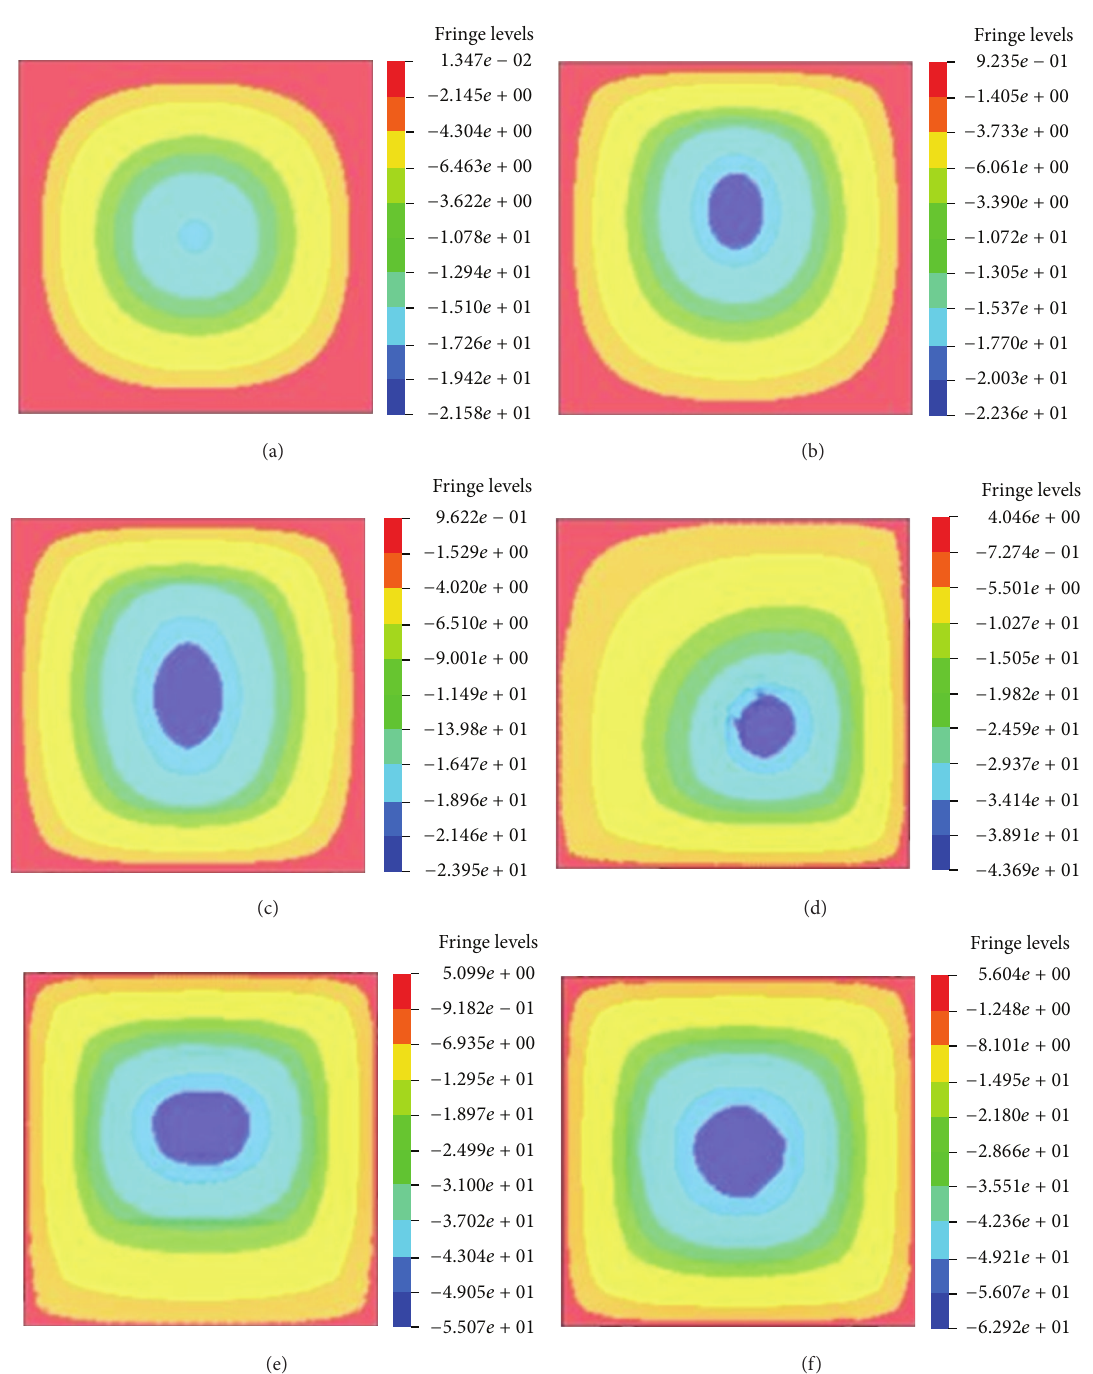
Figure 17: Displacement contours of RC slabs under different boundary